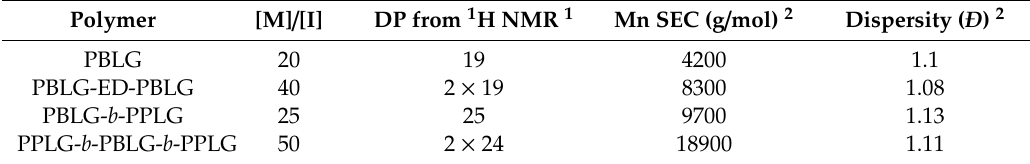
Table 1. Characteristics of the polypeptides obtained upon ROP (see Figure S2).